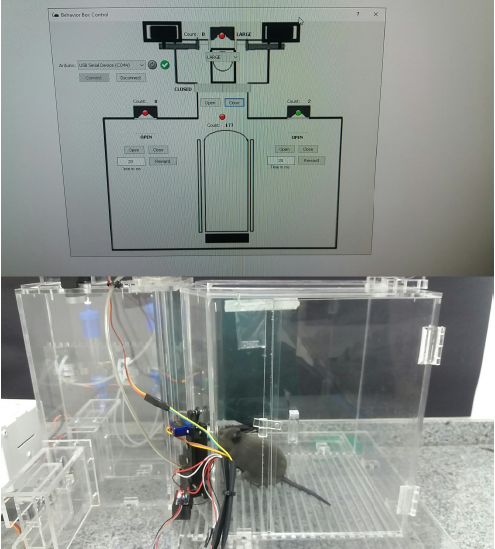
Figure 23. Remote control mouse in behavior box: activating the right reward sensor, referring to the narrow position of the